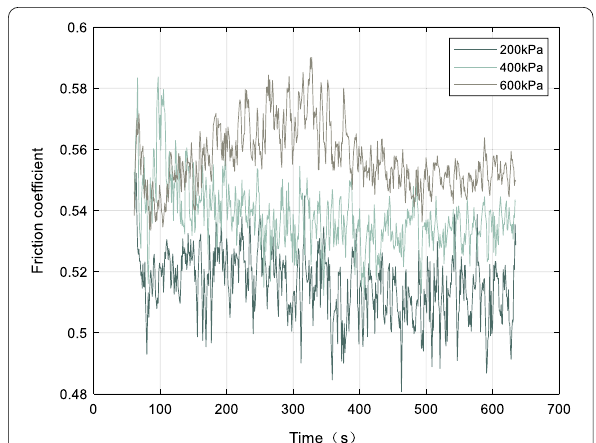
Fig. 12 Relationship between time and the friction coefficient under different normal